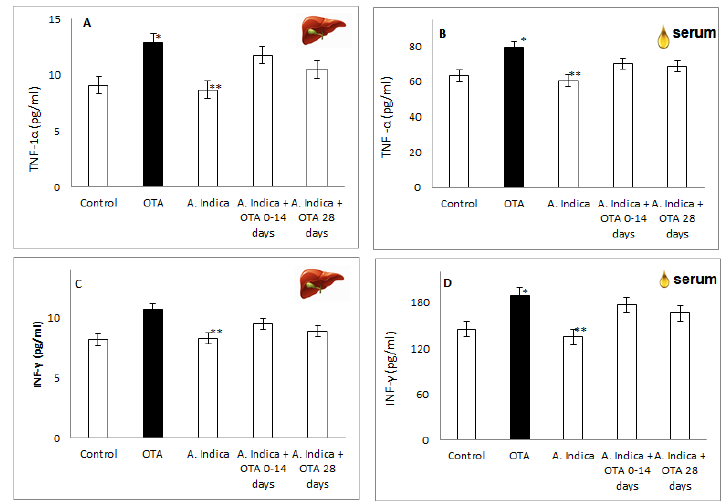
Figure 9. The concentration of TNF- α ( A , B ) and INF- γ ( C , D ) in liver homogenate/serum of OTA- injured group, compared to a group protected with A. indica oil alone, the group with A. indica oil + OTA and control; mean ± S.E. p < 0.05; (*) vs. controls; (**) vs. OTA.